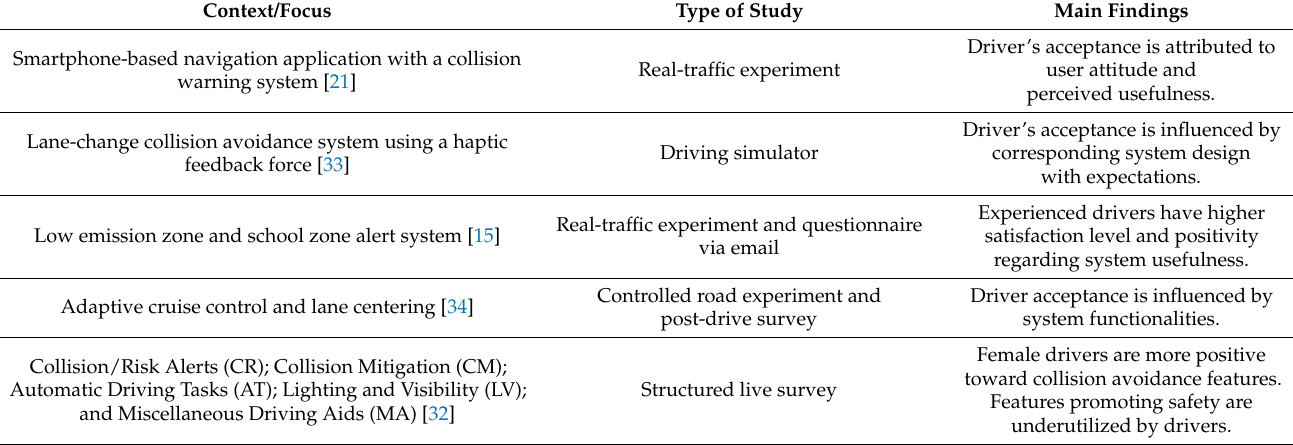
Table 4. Summary of previous work related to user acceptance of in-vehicle